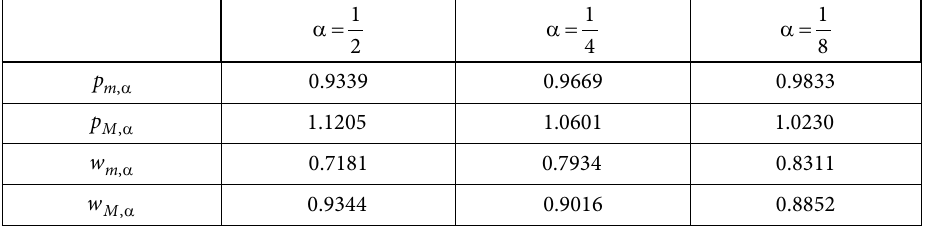
Table 4. Thresholding axes for different confidence values (source: Yang et al., 2018)